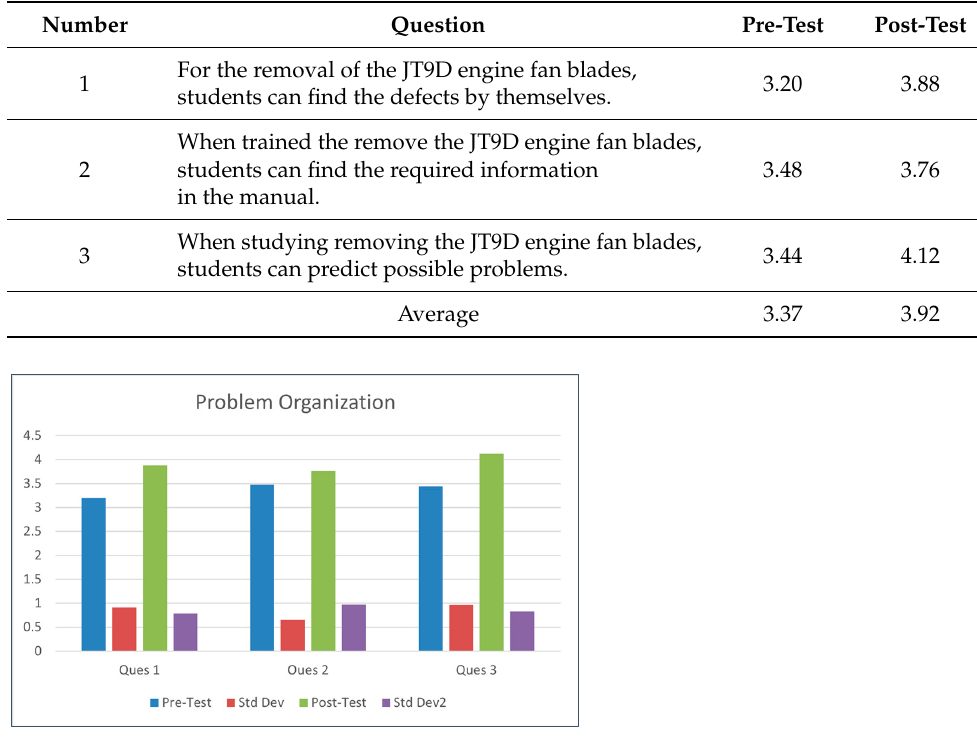
Figure 6. Students’ problem organization in the previous test and the post-test.